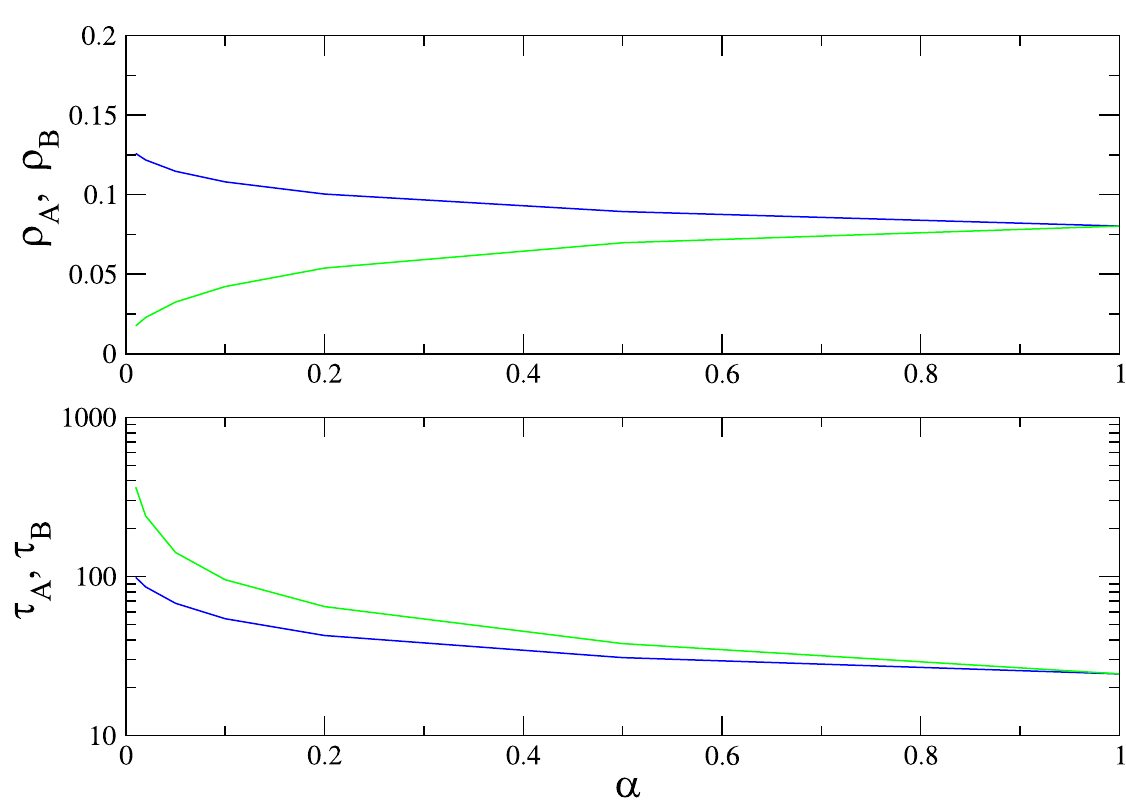
Fig 6. MF equations with periodic λ : Mean densities ρ B (dashed lines) and ρ A (solid) versus ω , for λ 0 = 1.1 and r = 0.1. Red: α = 0.1 and ρ A ,0 = ρ B ,0 = 0.25; black: α = 0.1 and ρ A ,0 = ρ B ,0 = 0.05; blue: α = 0.5 and ρ A ,0 = ρ B ,0 = 0.25. Populationdensities for α = 0.5 and ρ A ,0 = ρ B ,0 = 0.05 (not shown) are very similar to those for α = 0.1 and ρ A ,0 = ρ B ,0 =